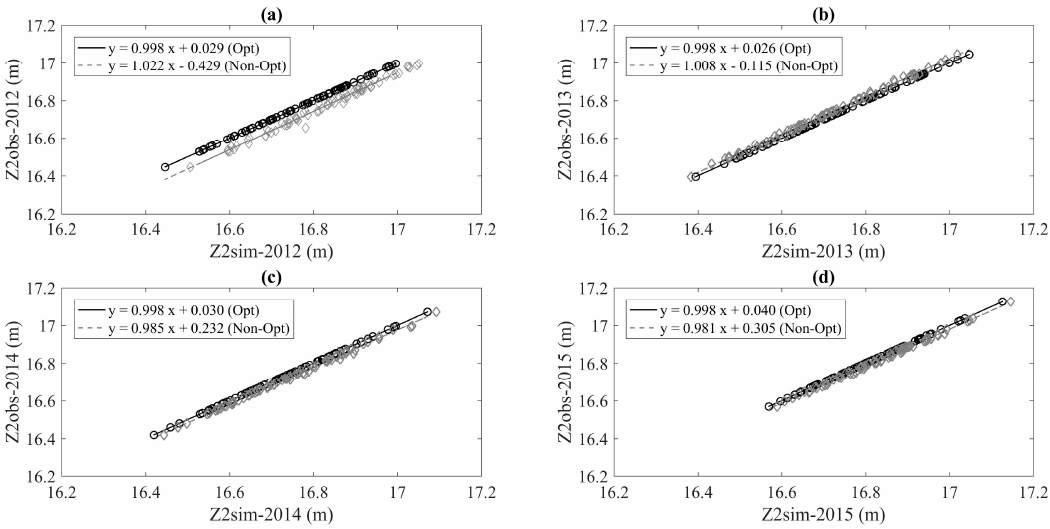
Figure 10. For every year: 2012 ( a ); 2013 ( b ); 2014 ( c ) and 2015 ( d ), the linear interpolation of Z2 obs and Z2 sim for both optimized and non-optimized models.